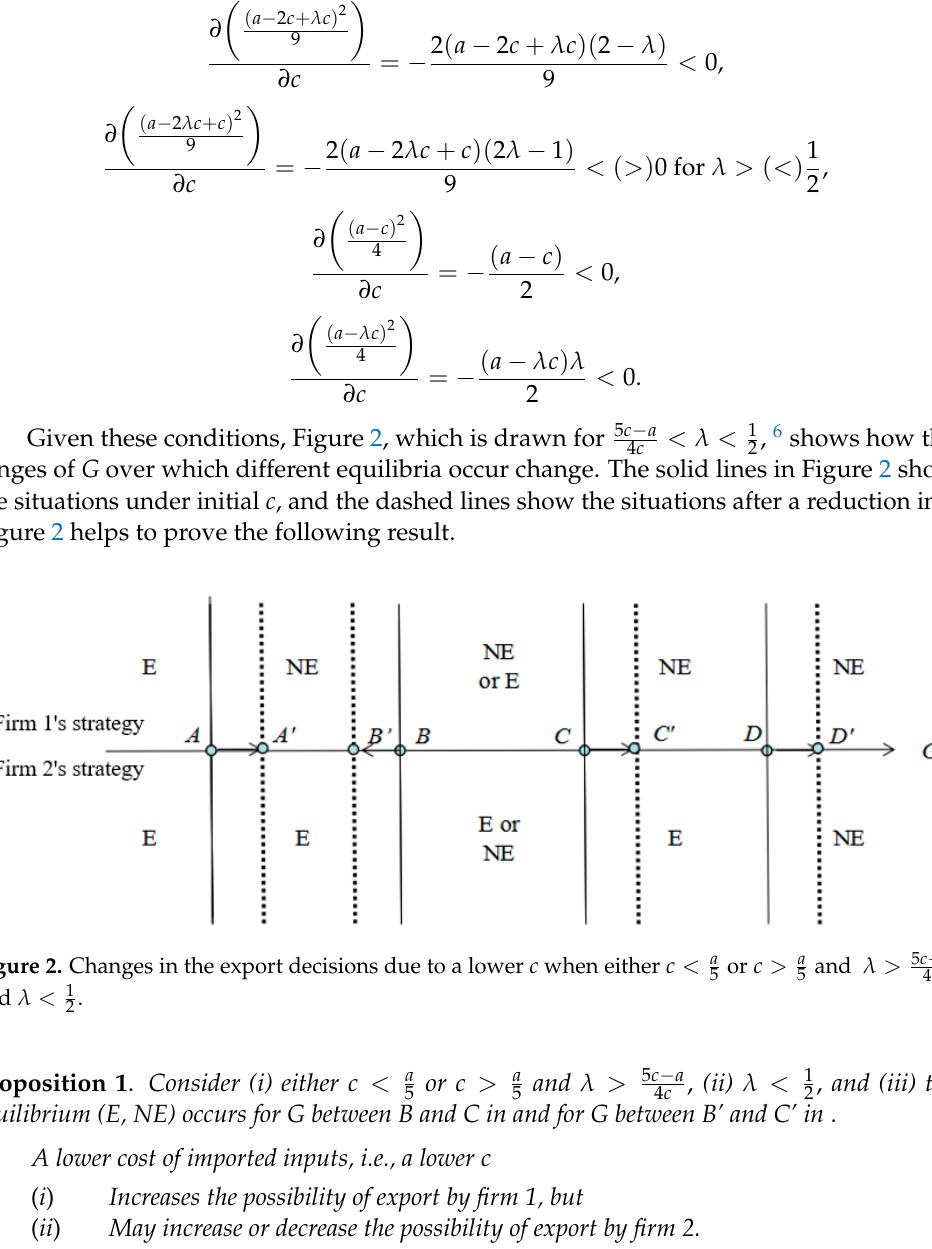
(cid:2873)(cid:3030)(cid:2879)(cid:3028) . (cid:2872)(cid:3030)